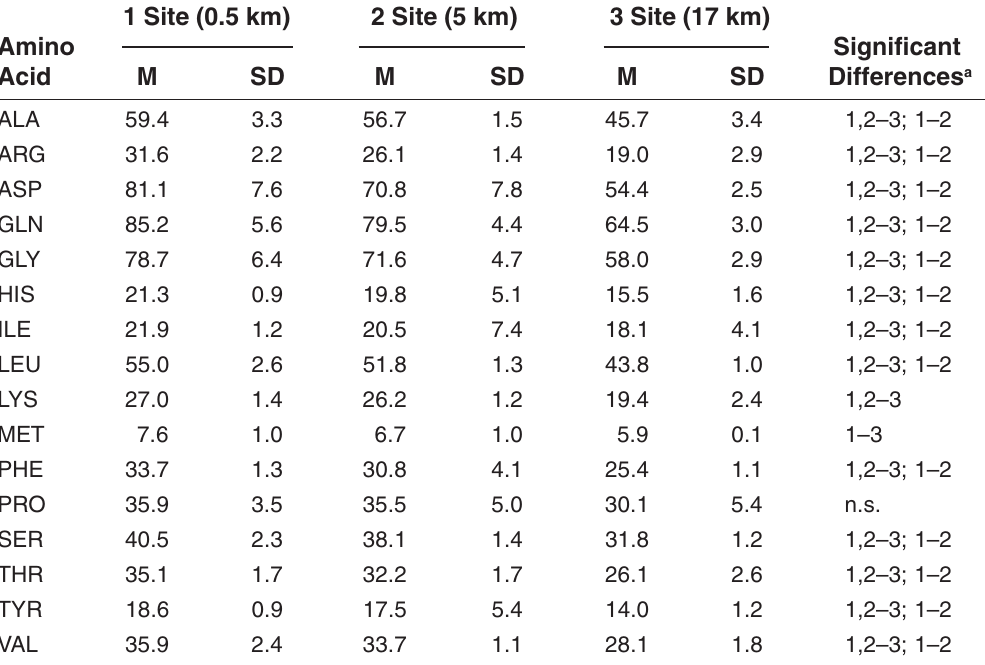
Content of Total Amino Acids (µmol g –1 d.w.) in Current-Year Needles of P. sylvestris Growing in the Area Affected by the Nitrogen Fertilizer Factory (December